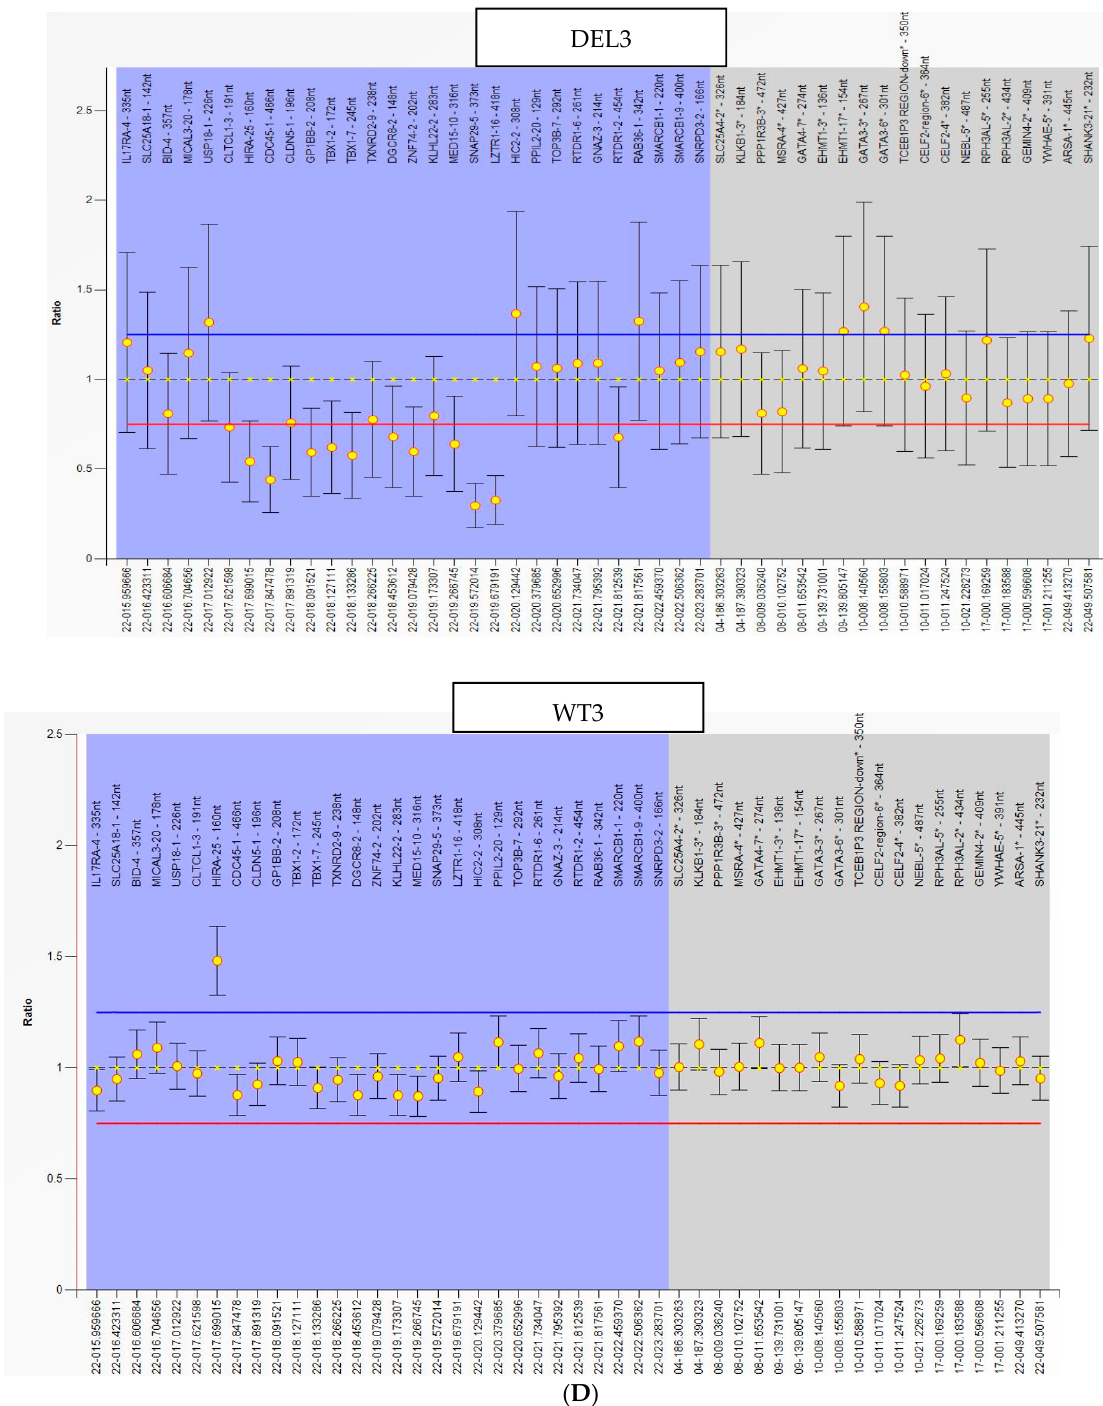
Figure A1. ( A ) Confirmation of stemness of iPSC lines using RT-PCR. OCT4 and NANOG are stem cell markers while SOX4 is a marker for differentiated cells. The size of the OCT4 PCR product is 380 bps, SOX4 is 240 bps, and NANOG is 260 bps. ( B ) Confirmation of stemness of iPSC lines using immunostaining. The iPSC culture was fixed and stained with the SSEA-4 antibody and DAPI (upper panel), and stained with TRA-1-60 and DAPI (lower panel). ( C ) Confirmation of karyotype of all iPSC lines. ( D ) Confirmation of genotypes of 22q11.2DS patients and controls with multiplex ligation-dependent probe amplification. For each plot, the x-axis is the probes’ position according to their genomic position as indicated. They y-axis is the log2 copy number ratio at each genomic position.